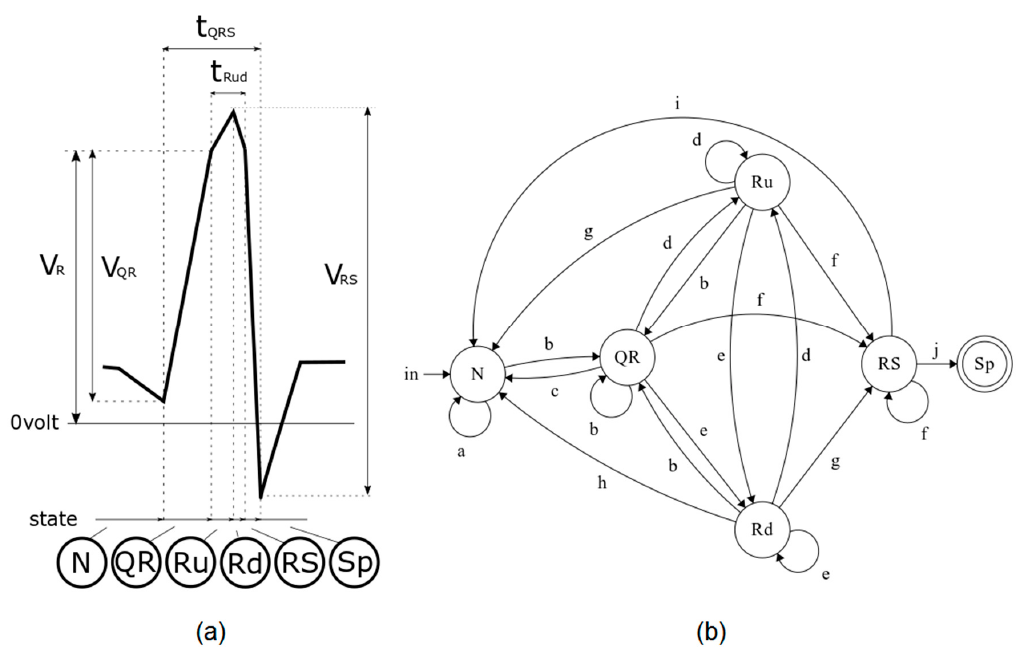
Figure 5. ( a ) Relation of the ECG signal sequence to the automata states and other ECG parameters and ( b ) the automata’s state transition diagram. Table 2. Automata recognizer transition functions.